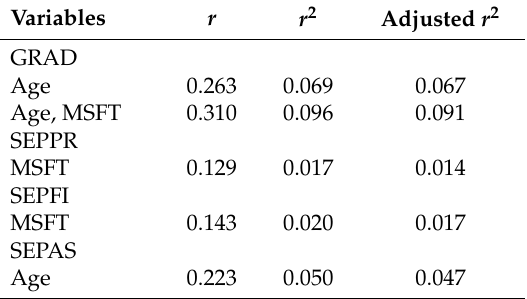
Table 3. Stepwise linear regression analysis for inclusion in each group (GRAD, SEPPR, SEPFI, and SEPAS) and age, height, body mass, push-ups, sit-ups, 75PR, VJ, MBT, and MSFT.